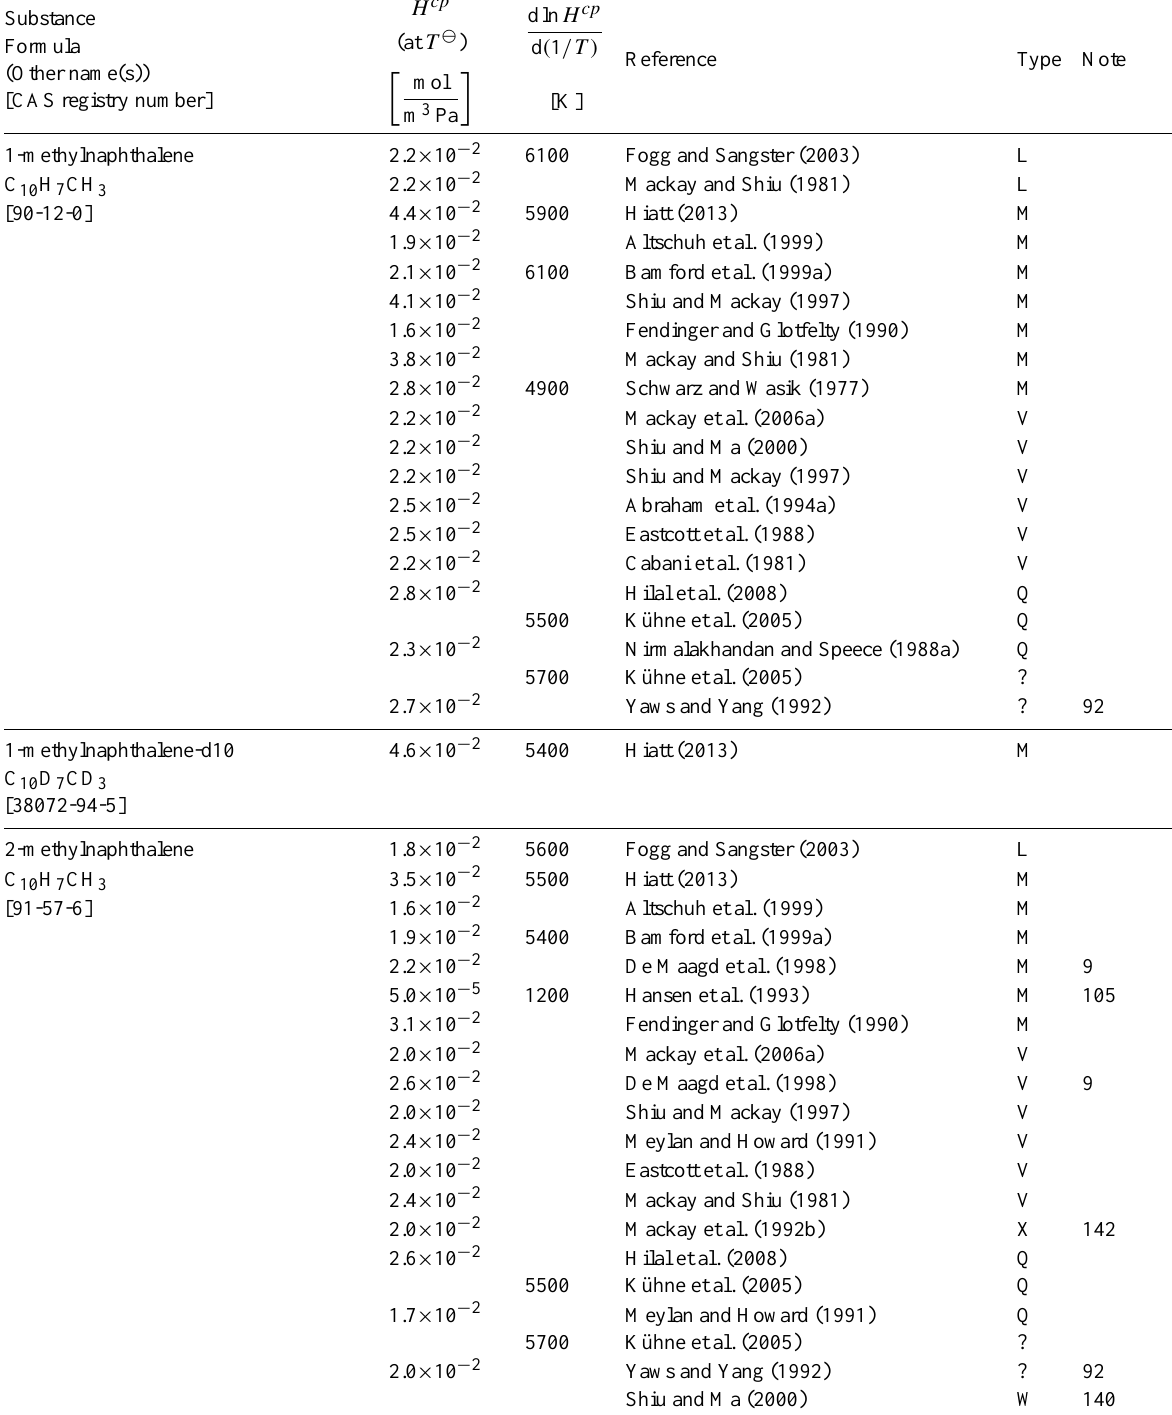
Table 6: Henry’s law constants for water as solvent